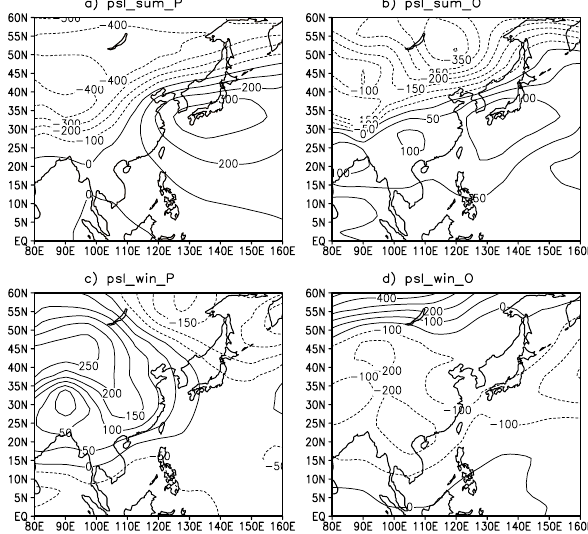
Fig. 5. Same as Fig. 3, but for sea-level pressure